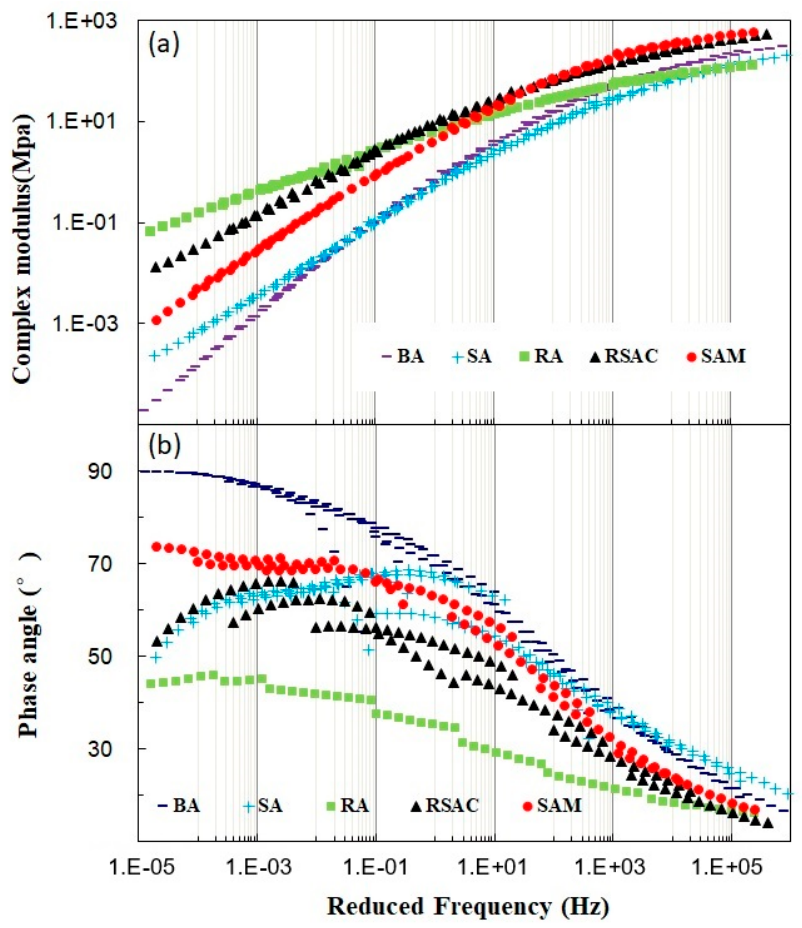
Figure 3. Master curves for ( a ) complex modulus and ( b ) phase angle of five asphalt samples.